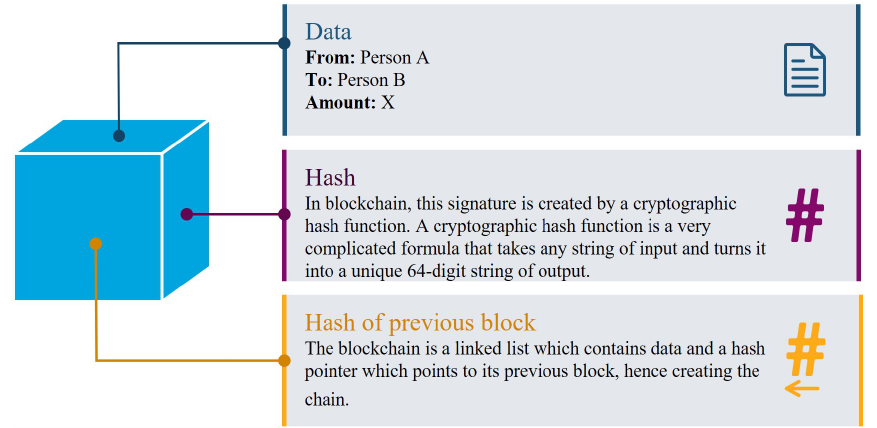
Figure 4. The basic block architecture of Blockchain and information encoded in each